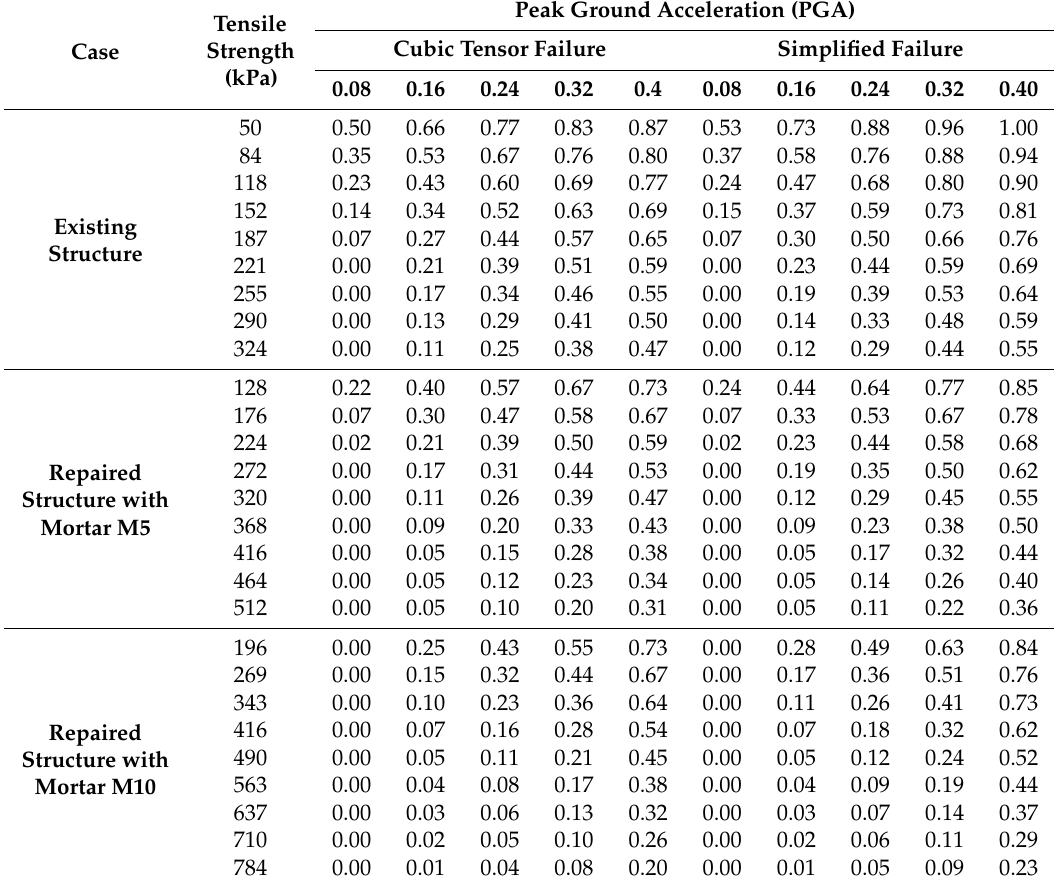
Table 9. Damage Indices for the structure before and after